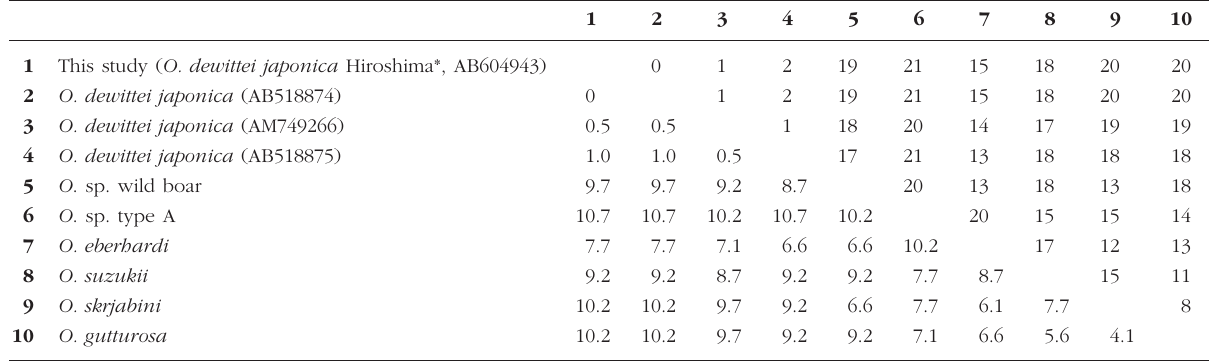
Table I. – Nucleotide differences over 196 sites of the CO1 gene sequences among Onchocerca species in